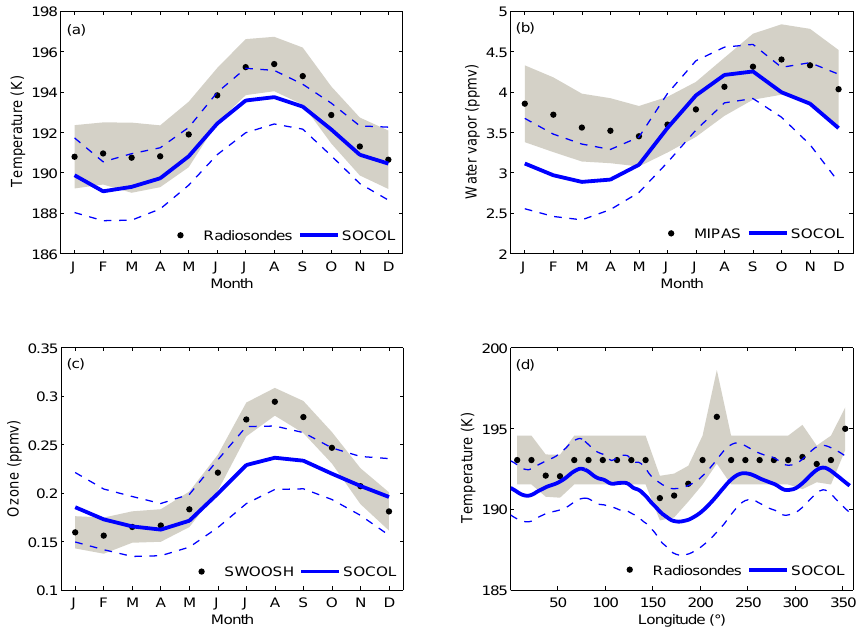
Figure 1. Modelled equatorial temperature, water vapour and ozone from the SOCOL v.3 RCP 6.0 simulation compared with observa- tions. (a) Climatological-mean modelled (4.2 ◦ N–4.2 ◦ S) CPT temperature (90hPa) compared with radiosonde measurements of the CPT (5 ◦ N–5 ◦ S) between 1961 and 1997. (b) Climatological-mean modelled (4.2 ◦ N–4.2 ◦ S) water vapour concentrations compared with MIPAS measurements (7.5 ◦ N–7.5 ◦ S) between 2005 and 2012 at 80hPa. (c) Climatological-mean modelled (4.2 ◦ N–4.2 ◦ S, 90hPa) annual cycle in ozone compared with merged SWOOSH observations (3.75 ◦ N–3.75 ◦ S, 82.5hPa) between 1984 and 2015. (d) Annual-mean modelled equatorial CPT temperature (90hPa) compared with radiosonde measurements of the CPT as a function of longitude. The grey shaded areas represent 1 standard deviation either side of the observations and the dashed blue lines indicate 1 standard deviation either side of model